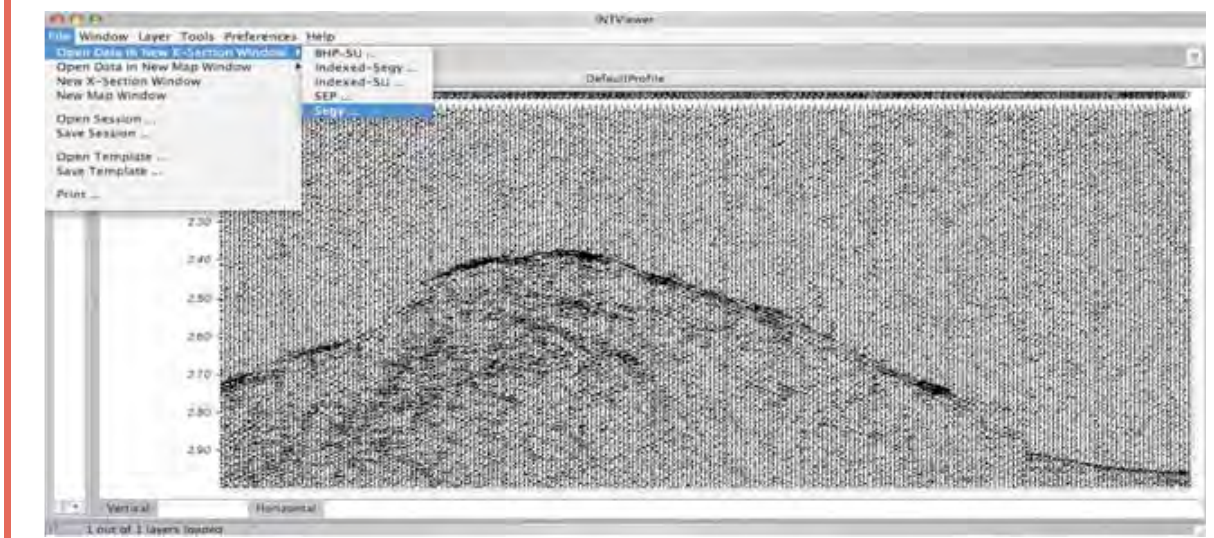
Figure 3. The SSDB utilizes the Java application INTViewer for displaying digital seismic pro fi les (SEG-Y format) which reside within the Digital Library. Data are displayed as an image onto the user’s computer screen, permitting evaluation of the data, as well as printing. INTViewer has several ways of displaying the seismic traces (de fl ection, positive color fi ll, etc.), and gain can be applied to enhance weaker signals. It can also display speci fi c sections of a SEG-Y fi le, for example, by limiting the traces and time range